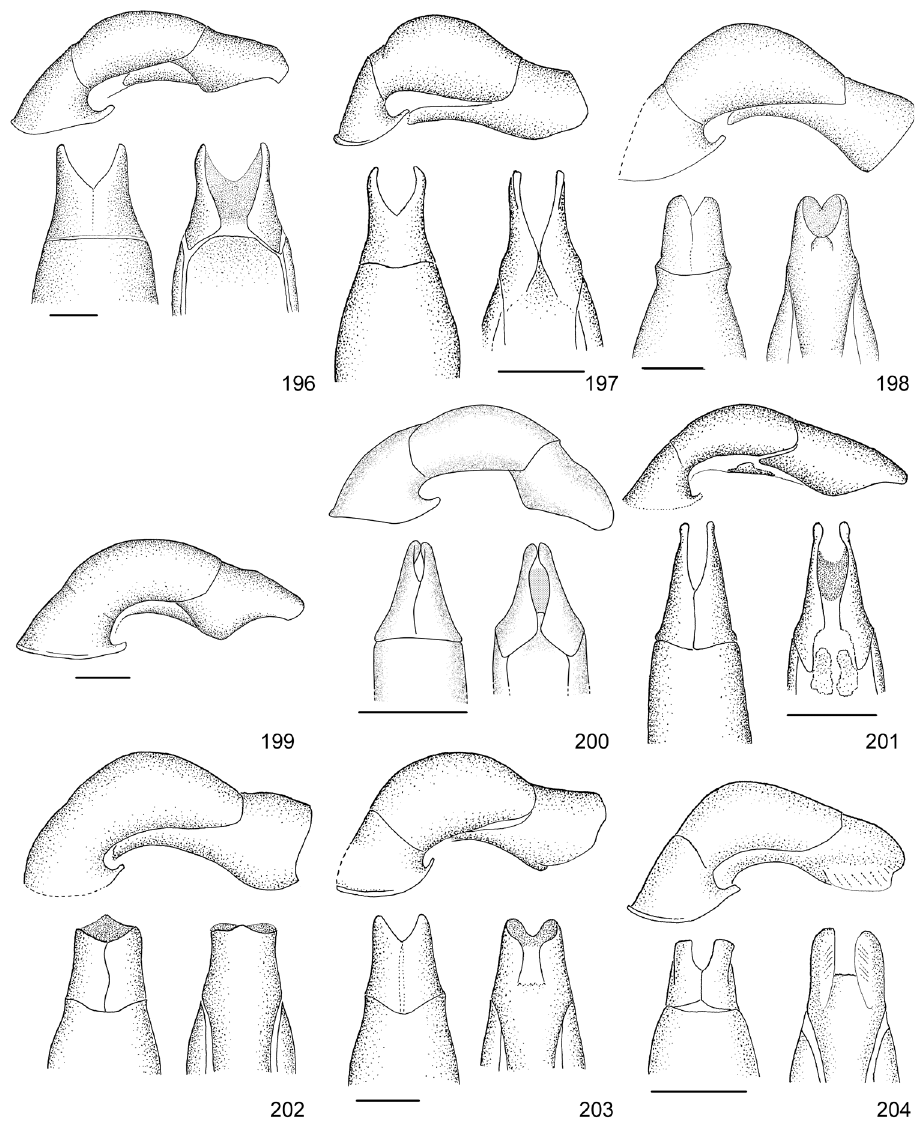
Figures 196–204. Shape of aedeagus, lateral view (top), dorsal view (bottom left), ventral view (bottom right). 196 Callistethus carbo (Río San Lorenzo, Guanacaste, MNCR) 197 C. chlorotoides (Estación Hitoy Cerere, Limón, MNCR) 198 C. chontalensis (El Copal, Cartago, CEUA) 199 C. chrysanthe (Chiriqui, MNHUB) 200 C. chrysomelinus (San Luis, Puntarenas, MNCR) 201 C. flavodorsalis (Finca Cafrosa, Puntarenas, MNCR) 202 C. fuscorubens (La Esquadra, Puntarenas, MNCR) 203 C. granulipygus (Ran- cho Quemado, Puntarenas, MNCR) 204 C. jordani (Estación Cacao, Guanacaste, MNCR). Scale bars: 1 mm. Figs 196–199, 201–204 modified from Filippini et al.